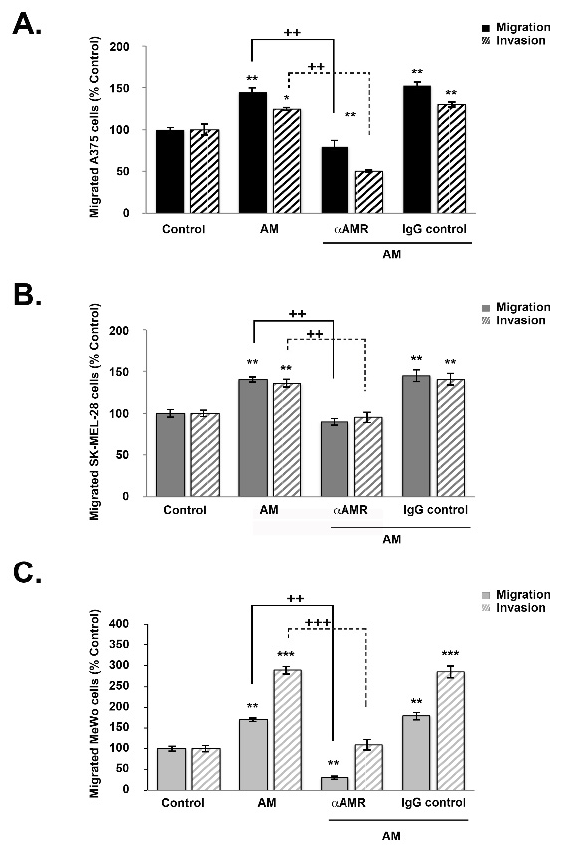
Figure 4. AM regulates melanoma cell migration and invasion in vitro. ( A – C ) The bottom wells of all chambers were filled with DMEM for A375 and SK-MEL-28 cells or MEM for MeWo cells con- taining 2% fetal bovine serum in the presence of control buffer (control) or AM (10 − 7 M). A375 (( A ), 2 × 10 4 cells), SK-MEL-28 (( B ), 2 × 10 4 cells), or MeWo (( C ), 1 × 10 5 cells) cells pretreated for 30 min with α AMR (70 μ g/mL) or control IgG (70 μ g/mL) were placed in the upper chamber and incubated for 16 h at 37 °C. The cells that migrated were stained with 4 ′ , 6 ′ -diamidino-2-phenylindole and counted at 50x magnification using a microscope. Data are expressed as the number of migrated cells in 10 high-power fields, and the values represent the mean ± SD of four independent experi- ments, each performed in triplicate. The asterisk (*) is used for comparison to control cells (* p < 0.05; ** p < 0.01; *** p < 0.001) and the plus symbol (+) is used for comparison to AM-treated cells (++ p < 0.01; +++ p <